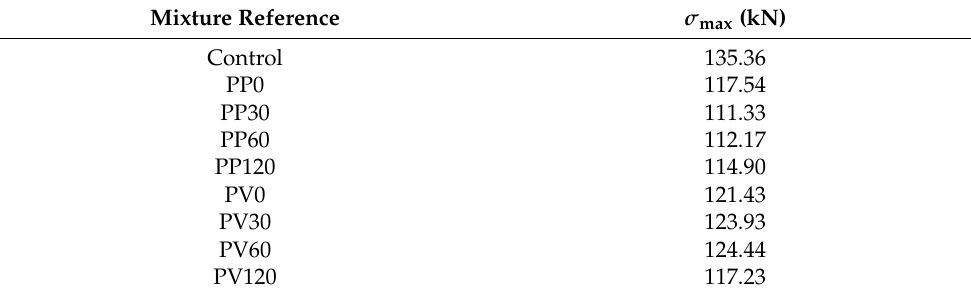
Table 3. Peak compressive strength ( σ max ).